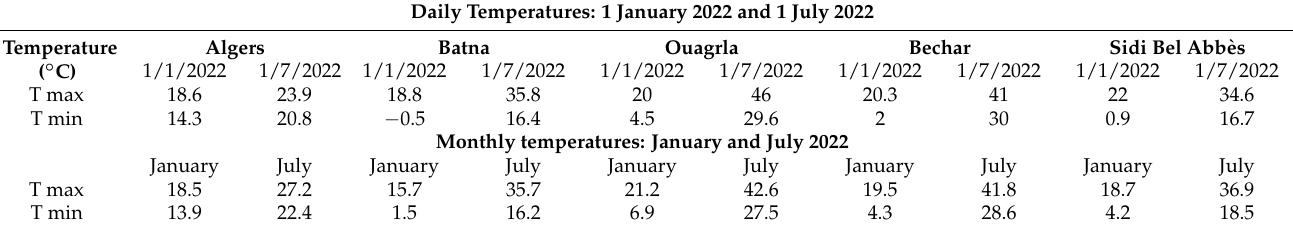
Table 2. Temperature data of study sites